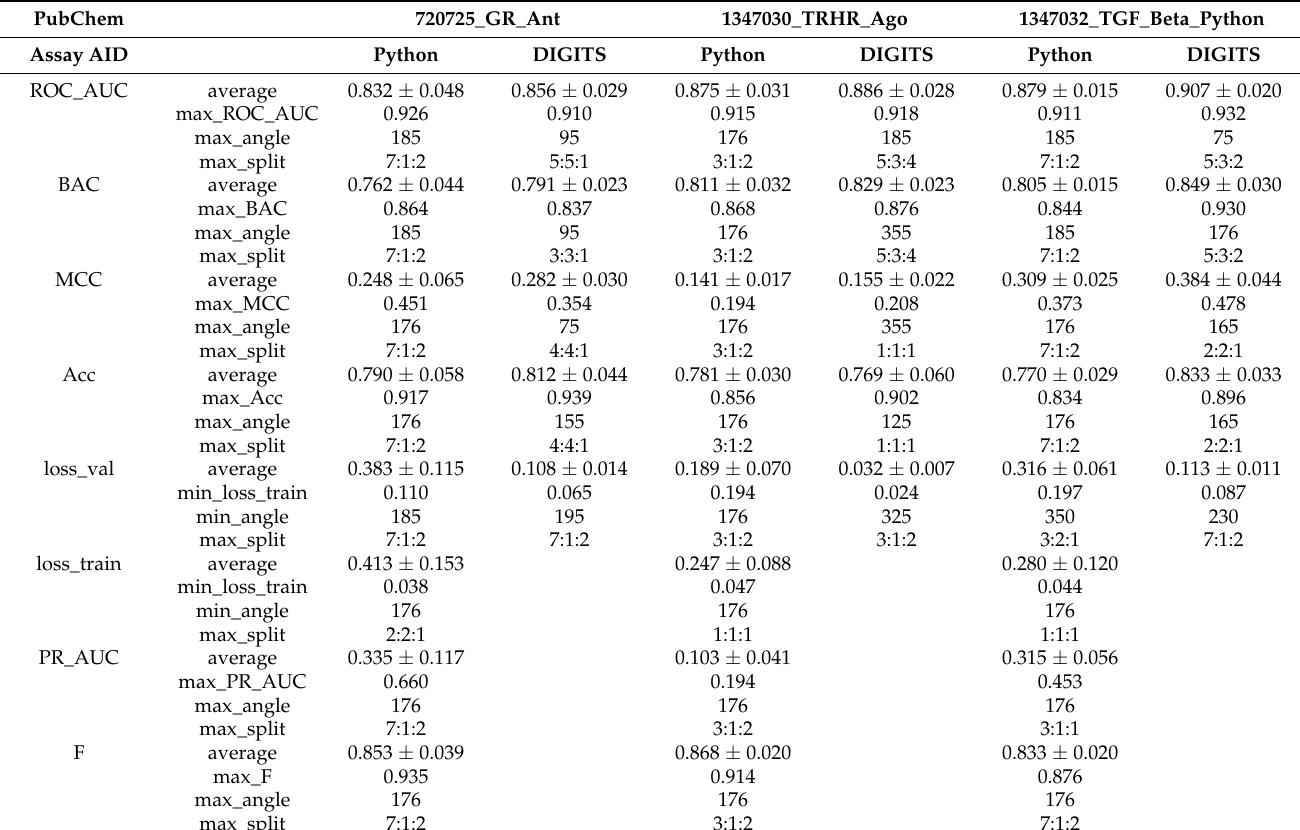
Table 3. Performances with angles using two DeepSnap systems of the four MIE